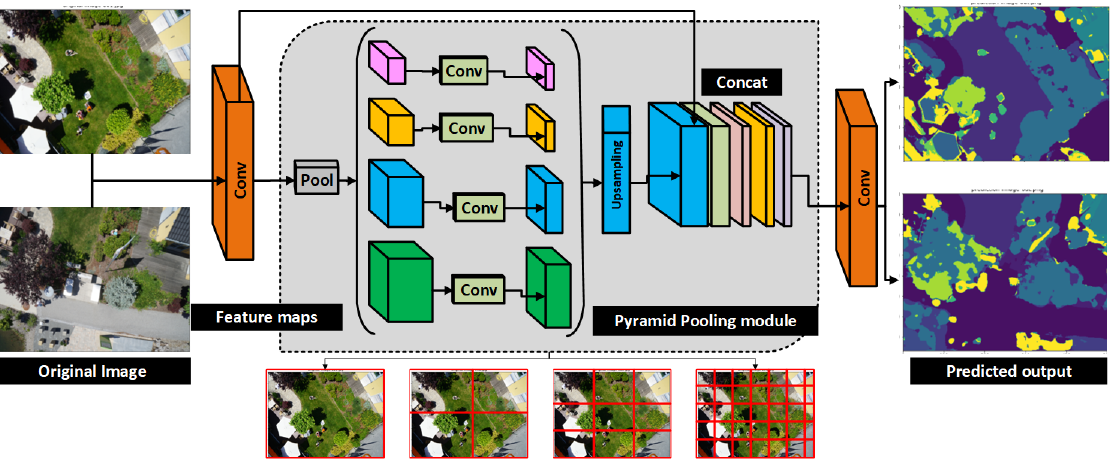
Figure 4. The general architecture of the deep learning-based segmentation model used for the segmentation of multiple objects using aerial drone data